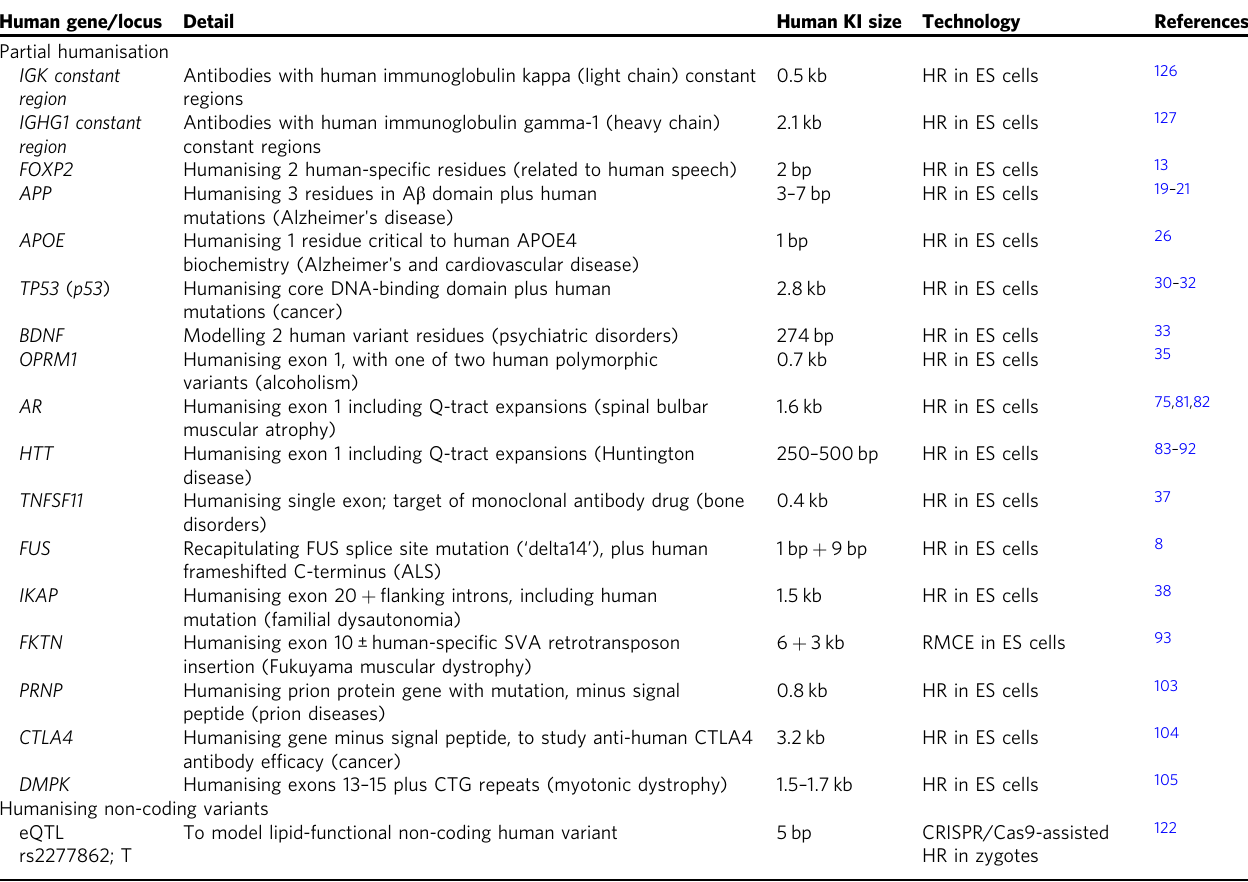
Table 1 Examples of partial and smaller scale genomically humanised mice created for different investigations Human gene/locus Detail Human KI size